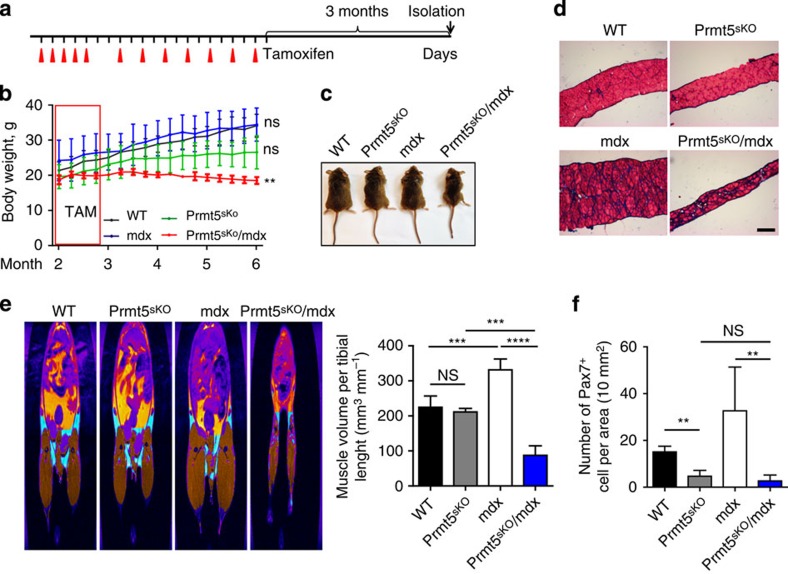
Continuous muscle regeneration depletes the MuSC pool of Prmt5sKO mice.(a) Schematic outline of the TAM administration and analysis of wild-type (WT), Prmt5sKO, mdx and Prmt5sKO/mdx mice (n=3, each). (b–d) Prmt5sKO/mdx mice (n=3) show lower body weight (b,c) and thinner diaphragm (d) compared with WT (n=3), mdx (n=3) and Prmt5sKO (n=3) littermates 3 months after TAM administration. Scale bar, 100 μm (d). (e) MRI measurements of decreased and increased muscle volume (brown colour) in Prmt5sKO/mdx and mdx mice, respectively, 3 months after TAM administration (WT and mdx, n=5 each; Prmt5sKO, n=3; Prmt5sKO/mdx, n=4). Quantification of muscle volume normalized to tibia length is shown on the right. Error bars represent s.d.'s of the mean (t-test: ****P<0.0001; ***P<0.001; NS, P>0.05). (f) Decreased numbers of Pax7+ cells in TA muscles of Prmt5sKO/mdx mice (n=5) compared with WT (n=5 and mdx (n=3) littermates. The number of Pax7+ cells per 10 mm2 area was counted on cryosections. Error bars represent s.d.'s of the mean (t-test: **P<0.01; NS, P>0.05). Control (Ctrl): Pax7CreERT2+/−/Prmt5+/loxP; Prm5sKO: Pax7CreERT2+/−/Prmt5loxP/loxP. NS, not significant.